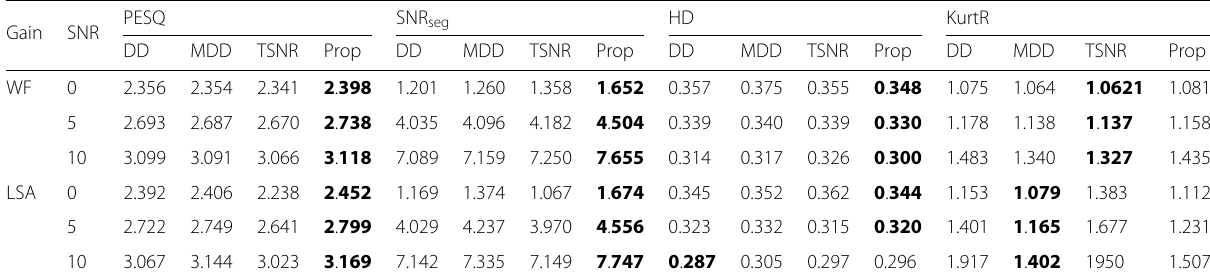
Furthermore, the overall results of the 10 participants have been evaluated using a statistical analysis to assess the differences between the ratings obtained for each a priori SNR estimation method in terms of overall quality. For this purpose, we used analysis of variance (ANOVA) to indicate a significant difference between scores if the level of significance is smaller than 0.05. A significant Table 8 Mean objective results with 75% overlap for factory noise